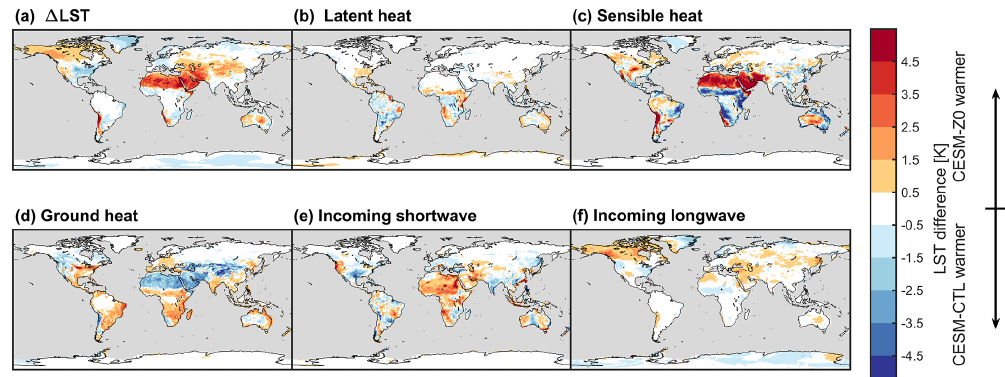
Figure A5. As Fig. A4 but for boreal